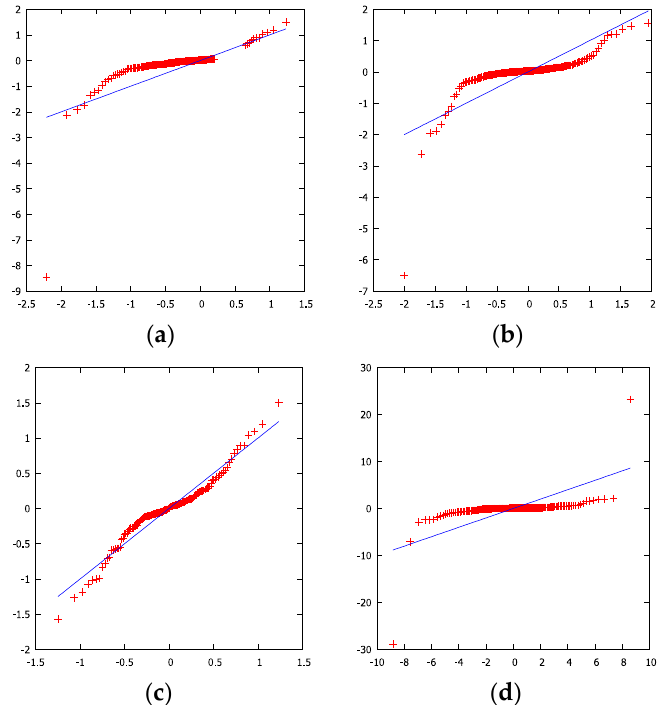
Figure 2. Q-Q plot of residuals: ( a ) northwest; ( b ) northeast; ( c ) centre; ( d ) south and islands.